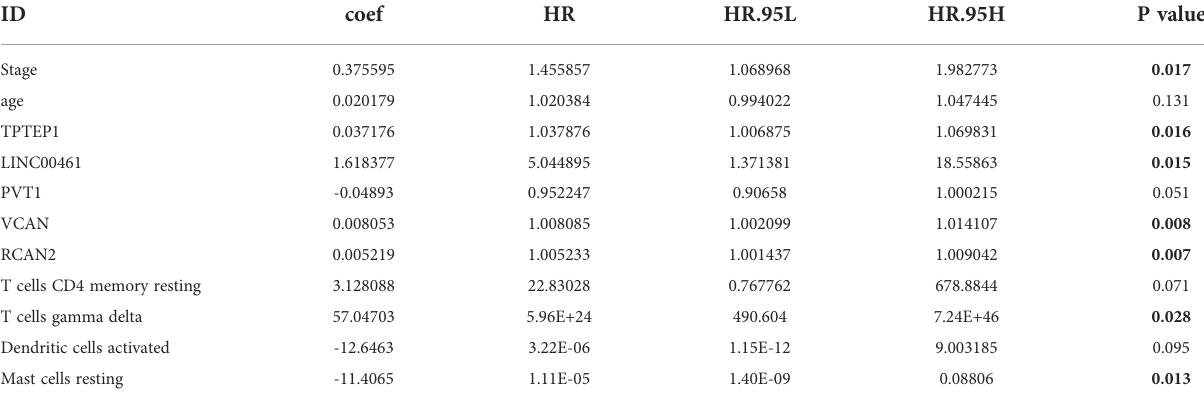
TABLE 2 Multivariate Cox regression analysis of comprehensive prognostic model.